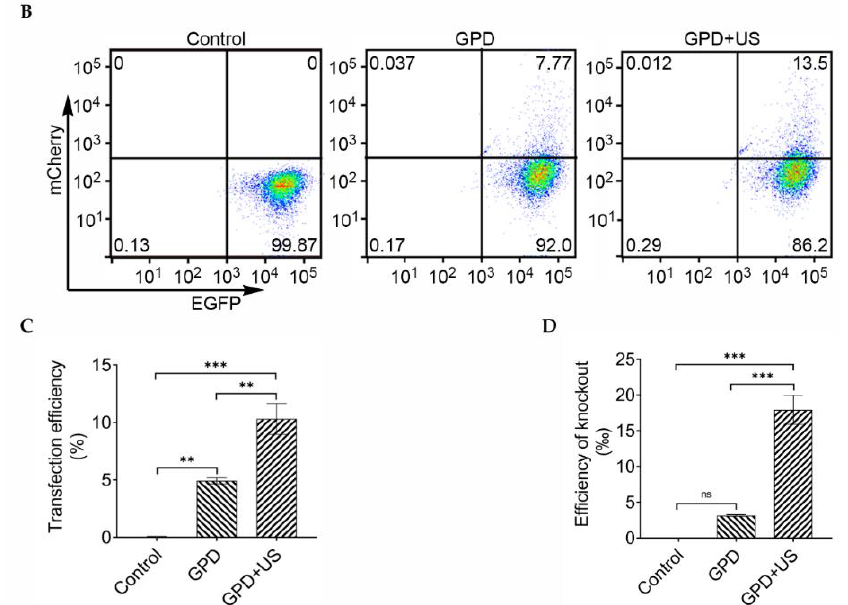
Figure 2. ( A ) Fluorescence images of Cas9- and EGFP-stably expressed 4T1 cells transfected with only pU6-sgRNA (EGFP)-mCherry (control), GPD, or GPD + US (GPD: the abbreviation of GVs-PEI-DNA). Scale bar = 200 μm ; ( B ) determination of the transfection efficiency by flow cytometry through counting of the red-emitting cells; ( C ) quantitative analysis of the mCherry-expressed cells from ( B ) ( n = 3); ( D ) determination of the EGFP knockout efficiency ( n = 3). ns denotes p > 0.05, ** p < 0.01, *** p < 0.001.